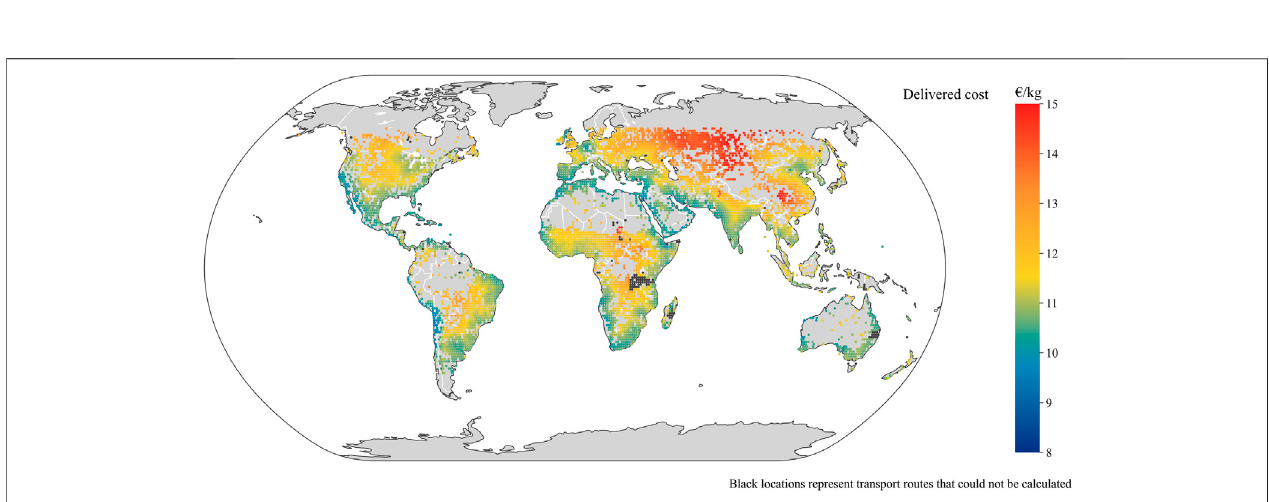
FIGURE8| Thetotal delivered cost (production and transportcost) ofH 2 required inCologne, Germany, inthebaselinescenario (100 kt/y AEelectrolyser in 2030, centralised reconversion), from each of the 5970 selected global locations. Black dots represent locations where possible transport routes could not be found. All transport mediums are considered. Results are from a Monte Carlo simulation with 1,000 iterations.